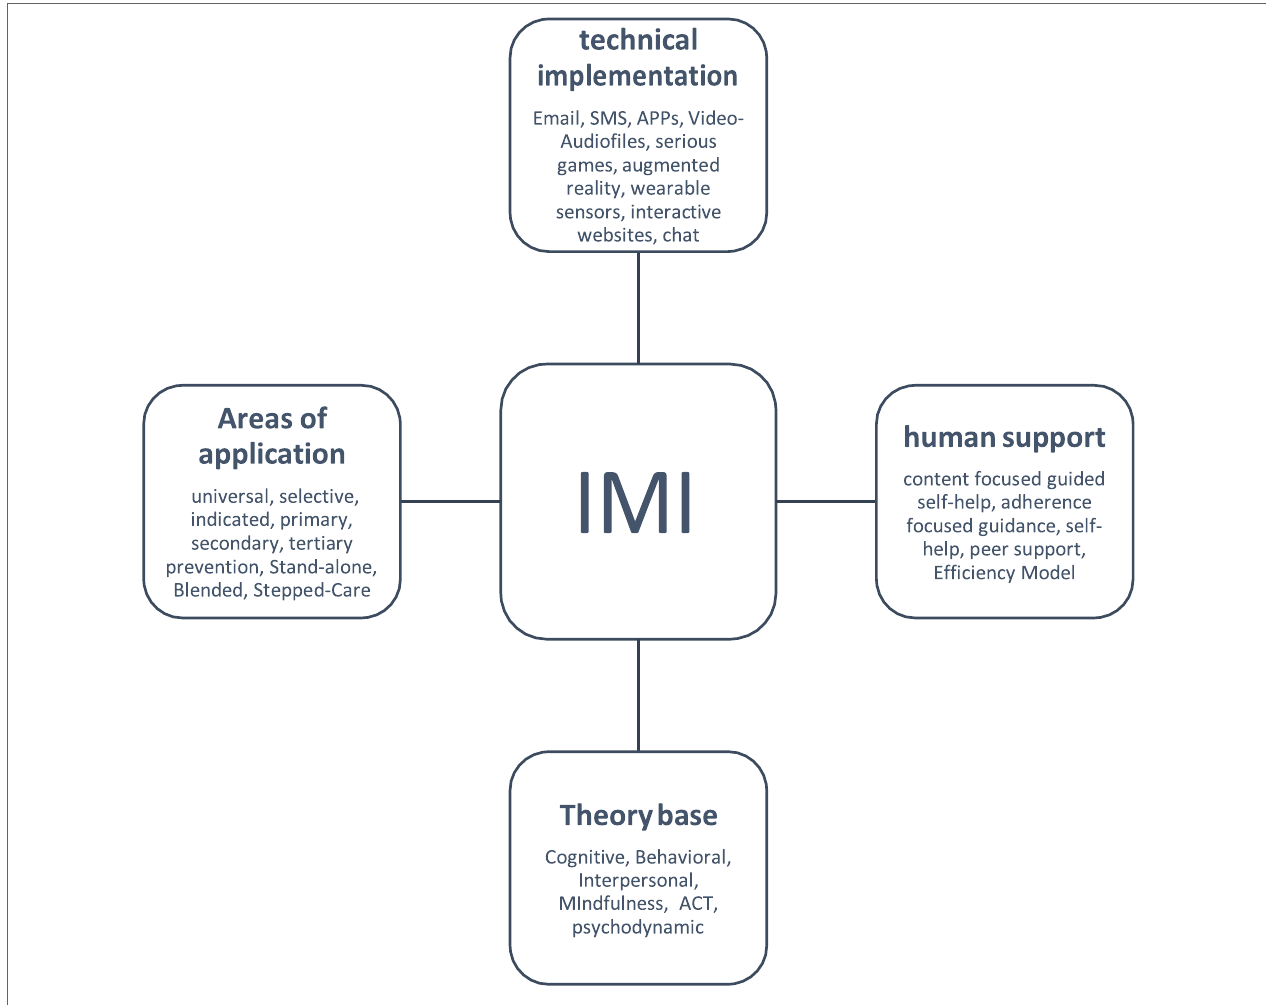
FiGURe 1 | Characteristics of Internet- and mobile-based interventions